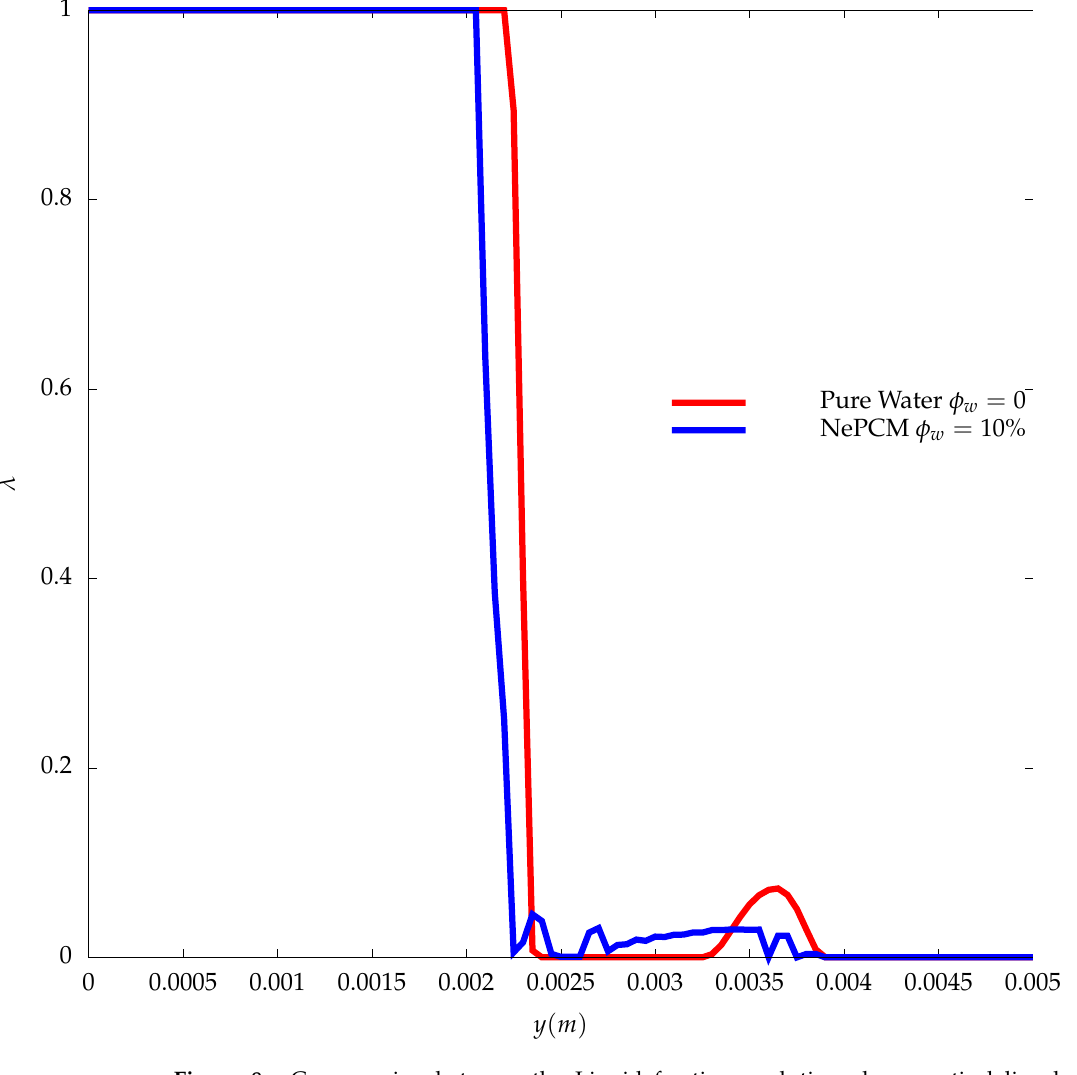
Figure 8. Compression between the Liquid fraction evolution along vertical line located at x = 0.005 mm, and a long the y -axis for the case of φ w = 0, and